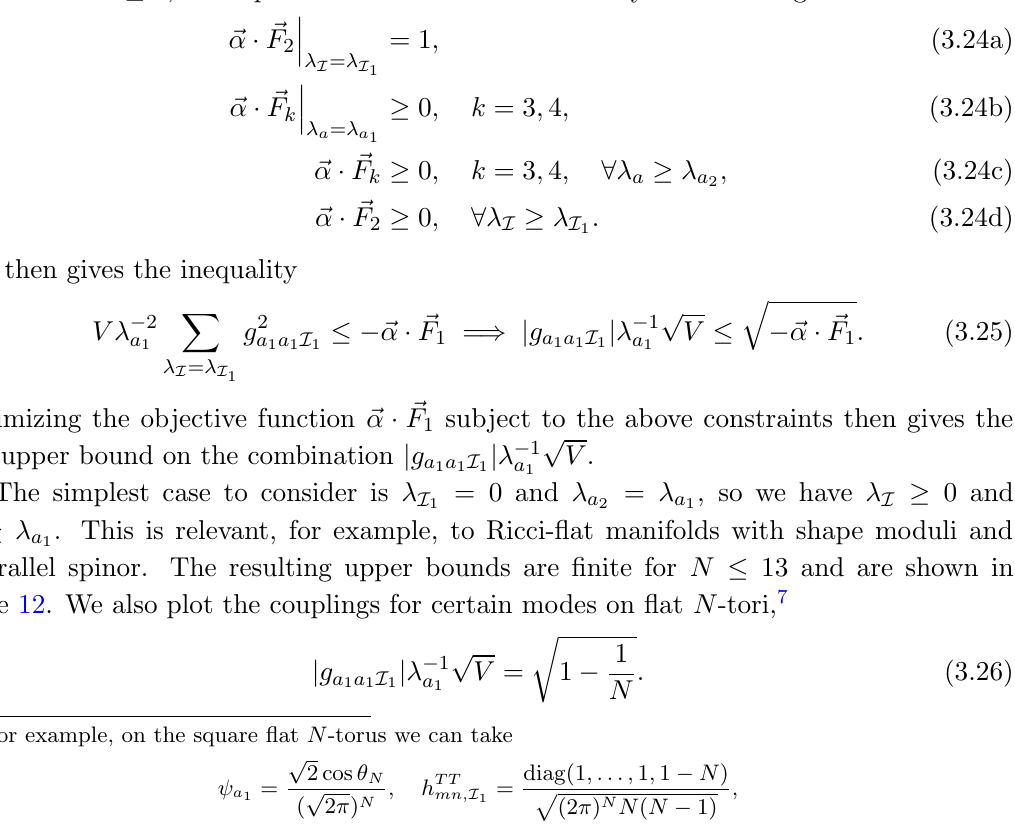
Figure 11 . Upper bounds on j g a R (cid:21) 0 and a Z 2 symmetry, assuming that (cid:21) I (cid:21) 0, (cid:21) (cid:0) corresponds to modes on long (cid:13)at tori. The (cid:12)lled circles correspond to the overlaps of the lightest nontrivial zonal spherical harmonics on S N . The dashed line is 2(3 (cid:21) a bounds approach as N ! 1 . This plot is identical to (cid:12)gure 10 in the region (cid:21) a